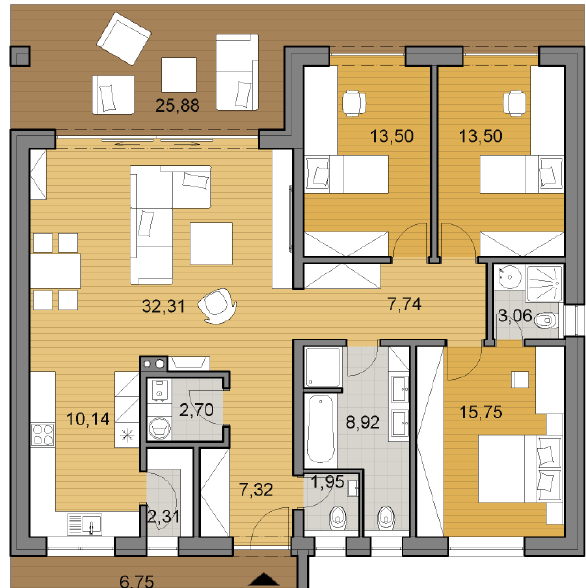
(DJS Architecture, s.r.o.,